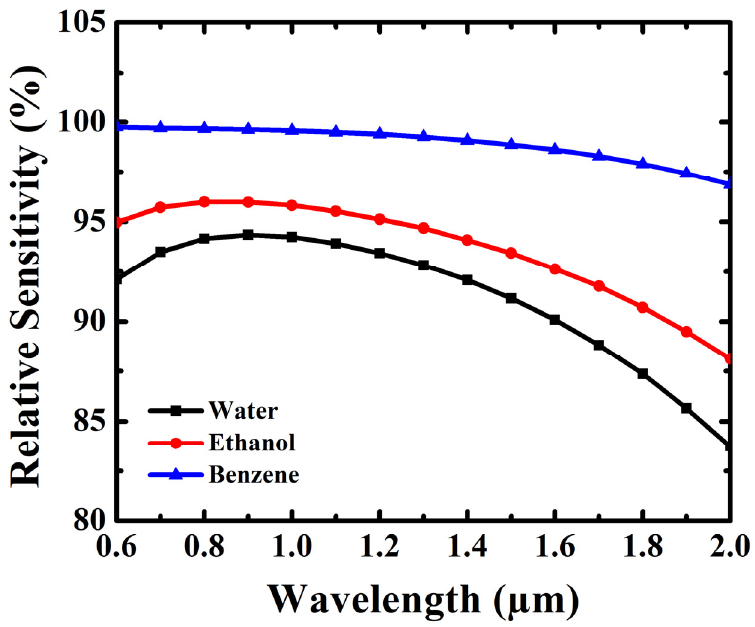
Figure 6. Relative sensitivity of the PCF sensor with water, ethanol and benzene, at different operating wavelengths.